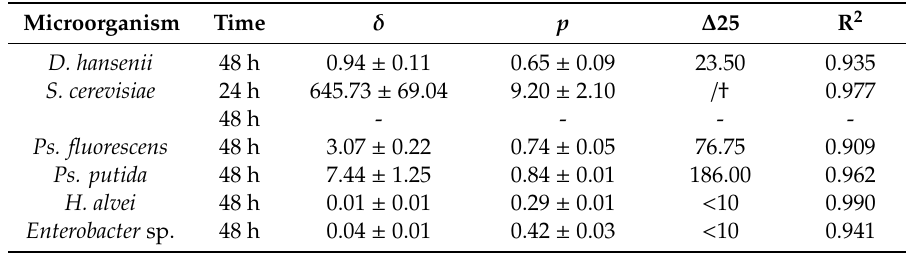
Table 2. Parameters of Weibull equation: δ , amount of propolis (ppm) to achieve a reduction in Growth Index of 1%; p , shape parameter ( p < 1, upward curve; p > 1, downward curve); ∆ 25, amount of propolis (ppm) to achieve a reduction of Growth Index of 25%; R 2 , determination coe ffi cient. Micro-dilution approach for low-level inoculum (3 log cfu / mL).